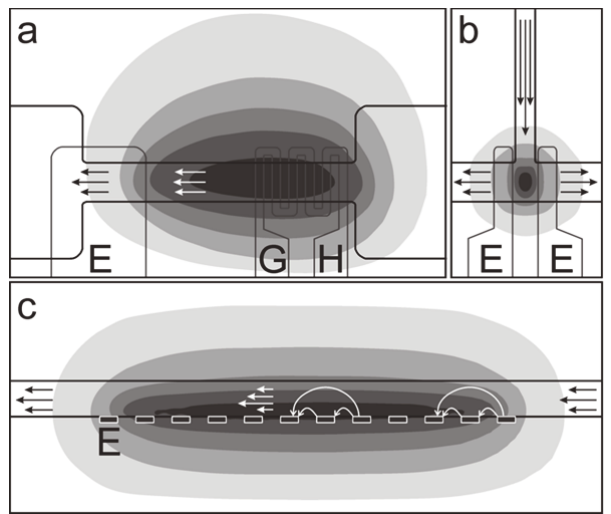
Fig. 12: Top- (a, b) and side-view (c) sketches of directly heated ETµP (a), T-channel ETµP (b), and ETTWµP (c) structures with temperature distributions in gray scaling (one gray step corresponds to approximately 1 K), fluid channel and metal- layer geometries. For the heat conductivities of the channel walls, bottom and cover see Stubbe et al. [2007]. Circumferences of field electrodes (E) and fluid channels are marked by thin and bold lines, respectively. G and H in (a) designate the common ground connector for field generation and the resistive heating meander. Straight arrows designate averaged medium velocities below the Maxwell-Wagner frequency (a and b) or in the β -dispersion range (c). Bent arrows in (c) sketch the effective AC and TW field